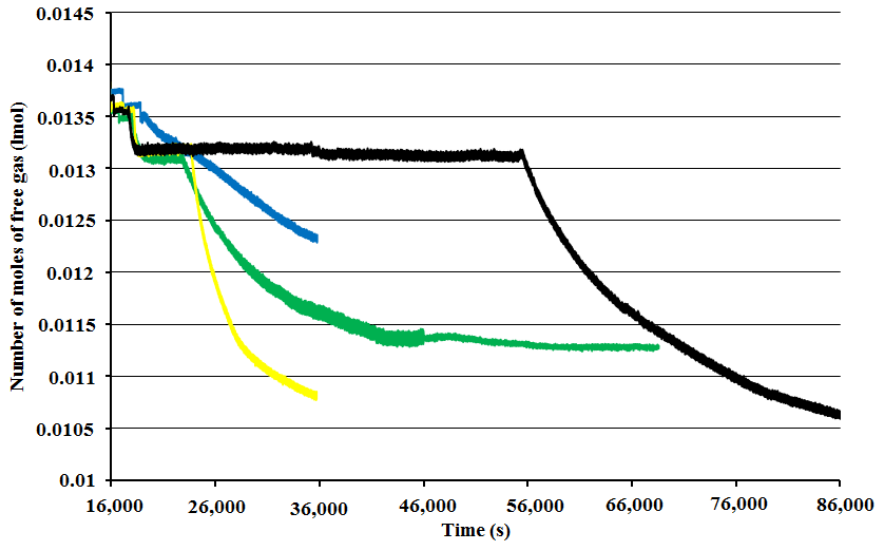
Figure 3. Number of moles of free gas for single-impeller experiments vs. time at starting rotation properties 2 ◦ C and 42.5 bars for full-baffle experiment (blue), half-baffle experiment (green), surface- baffle experiment (yellow), and no-baffle experiment (black).